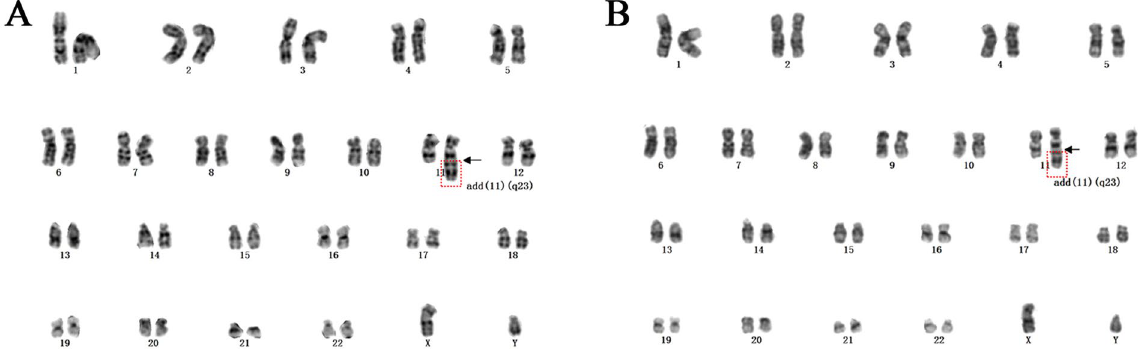
Figure 2. Cytogene analysis. G-banding karyotype of ( A ) leukemia cells of the patient and ( B ) CHH-1 cells. The cells show the same structural abnormality in the long arm of chromosome 11 which is indicated by arrows as the primary leukemia